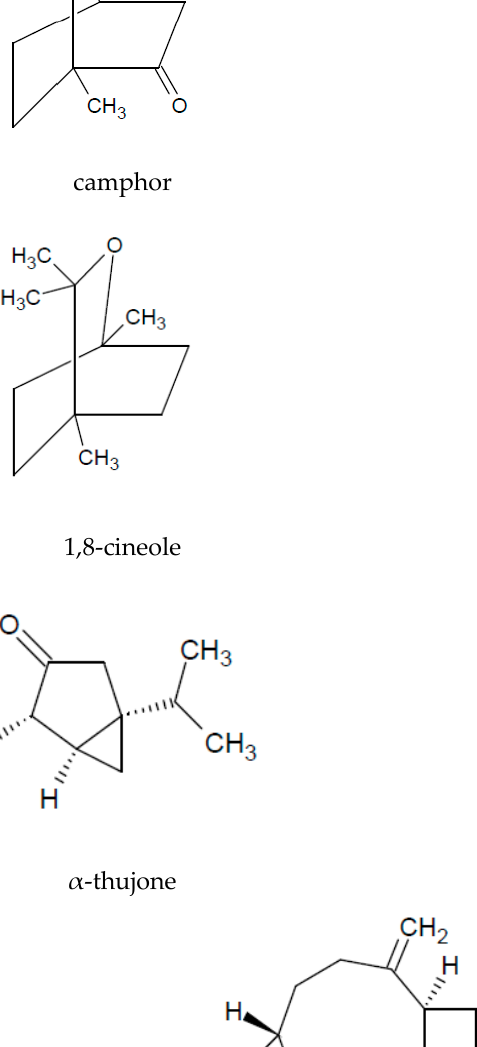
Table 4. Differences in the composition of essential oils from the herb of A. vulgaris of various